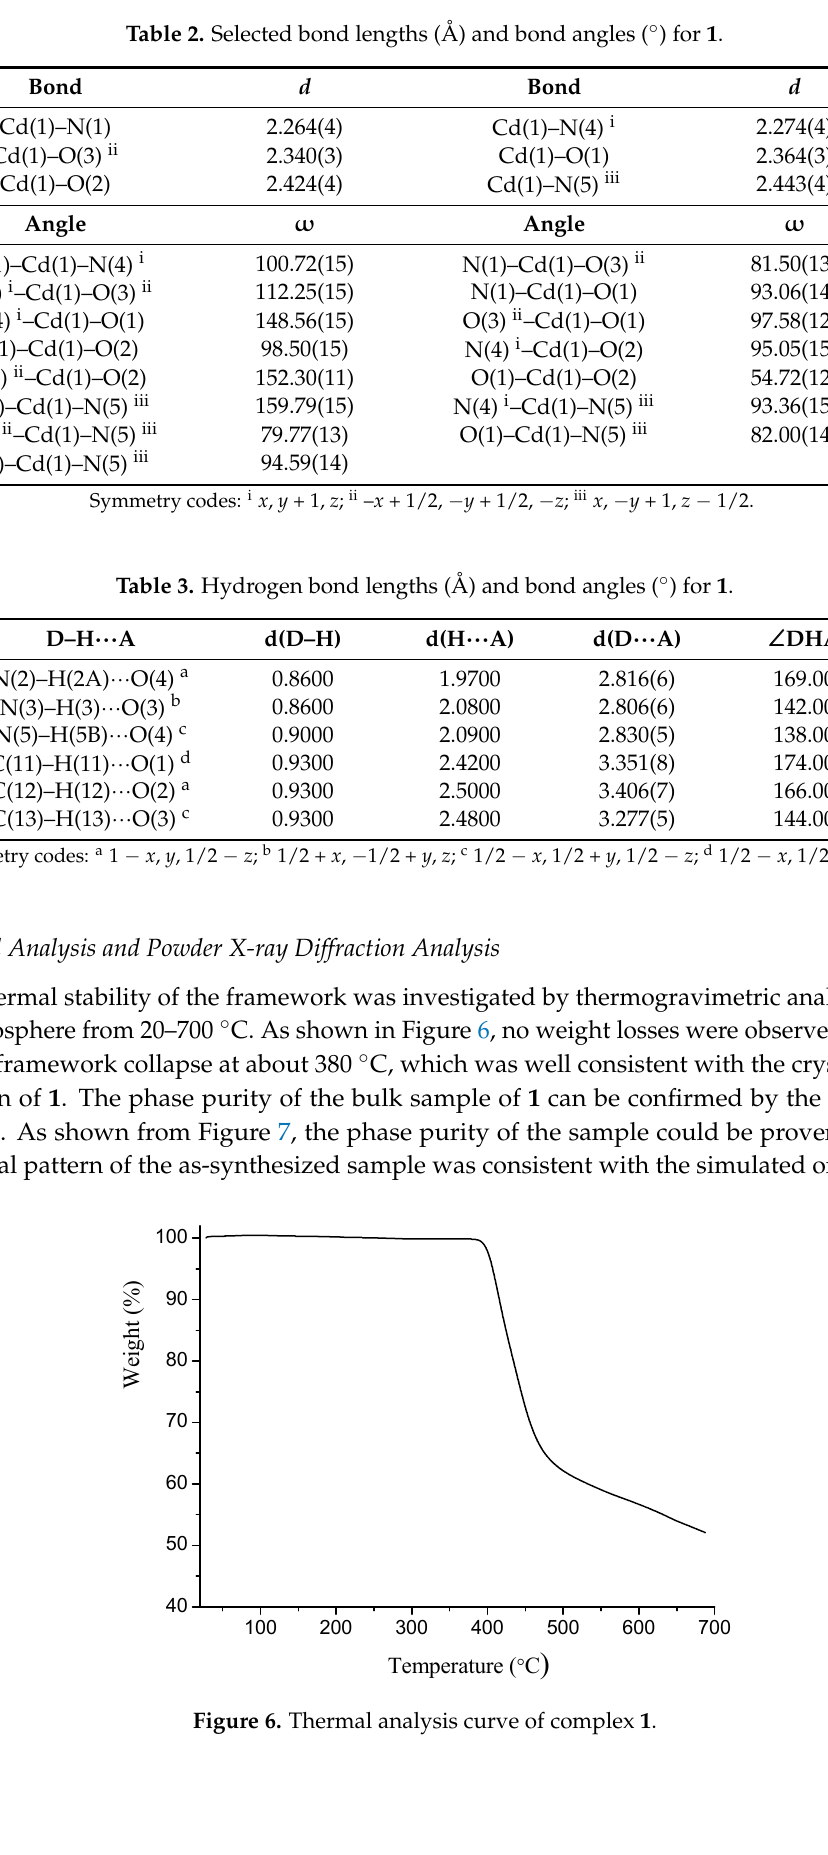
Table 2. Selected bond lengths (Å) and bond angles ( ◦ ) for 1 .